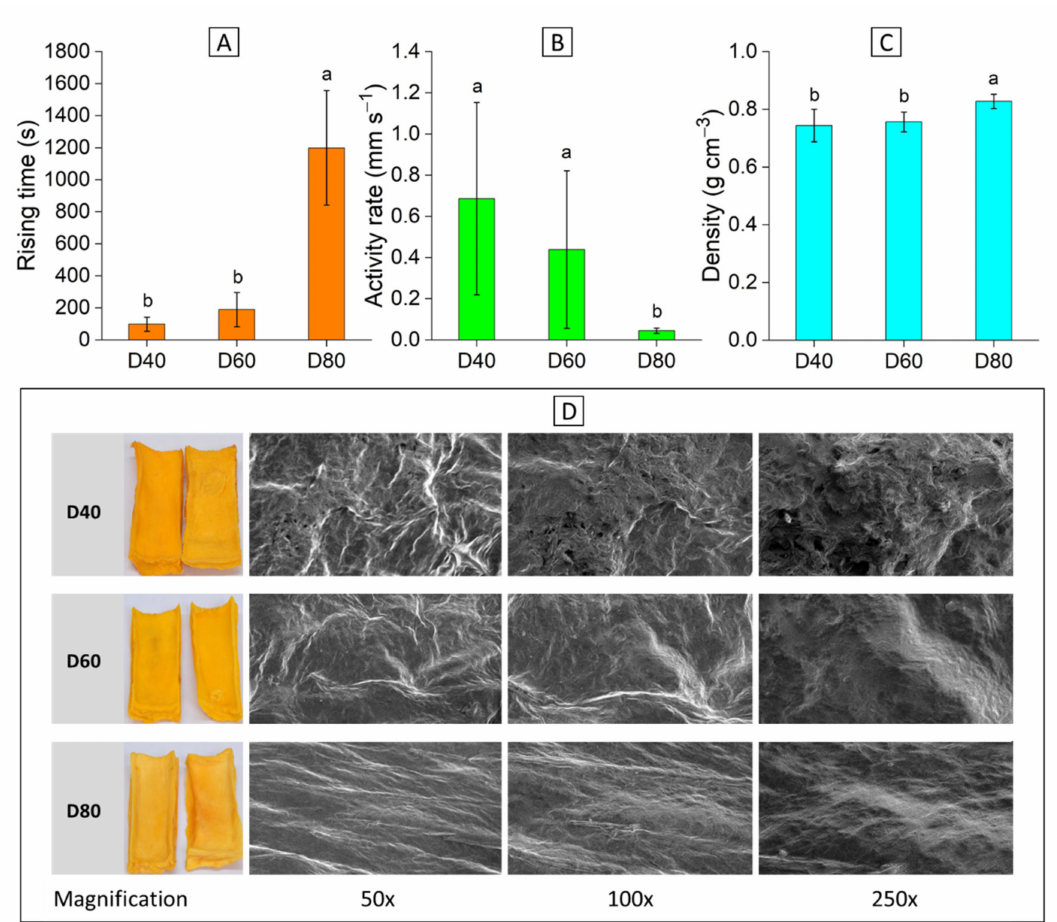
Figure 5. ( A ) Flotation time (s), ( B ) activity rate (mm s − 1 ), ( C ) density (g cm − 3 ) and ( D ) digital and SEM micrographs of the surface of mango slices dried at 40 ◦ C, 60 ◦ C and 80 ◦ C. Different letters in a graph indicate significant differences at p <